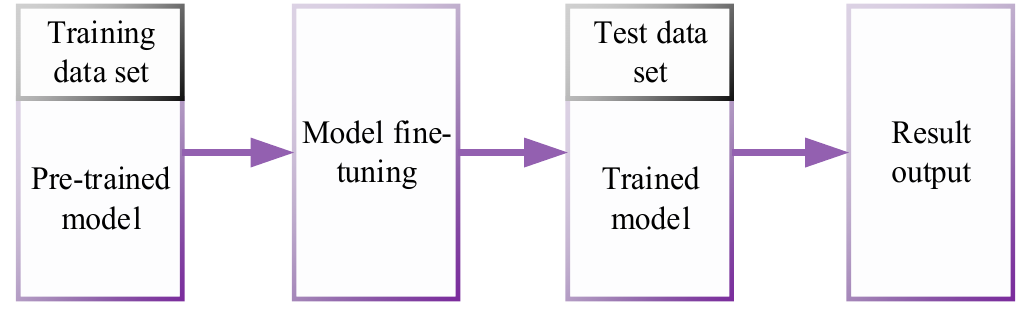
Figure 10. Parameter fine-tuning process.